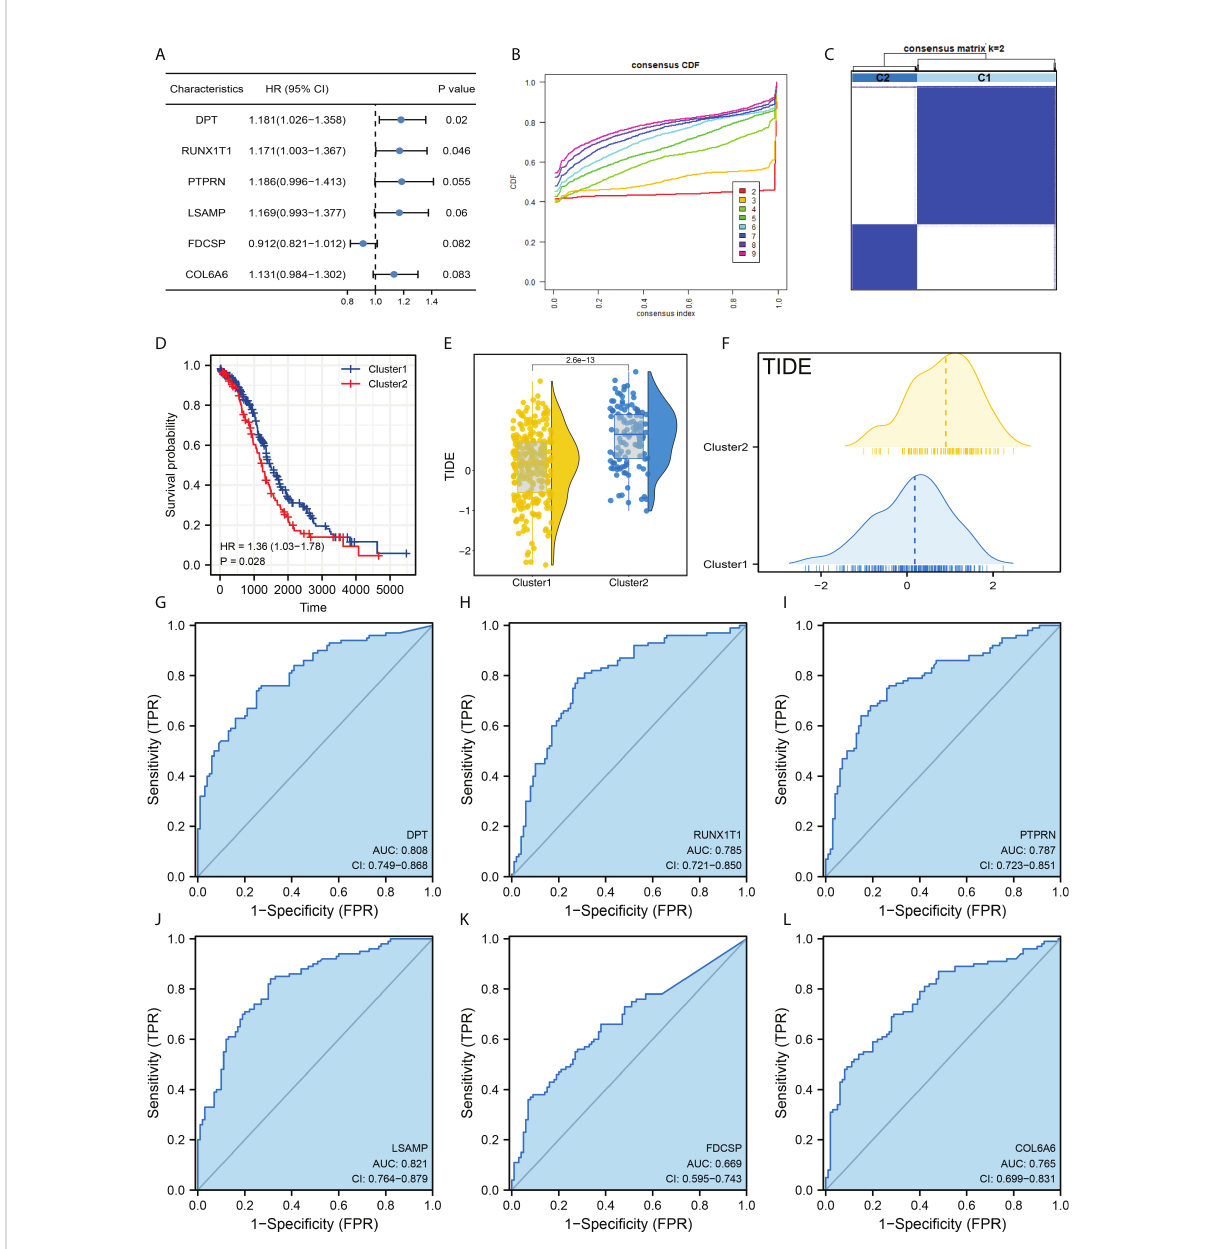
FIGURE 2 Molecular typing based on DPT, RUNX1T1, PTPRN, LSAMP, FDCSP and COL6A6. (A) Among all the characteristic genes, DPT, RUNX1T1, PTPRN, LSAMP, FDCSP and COL6A6 were identi fi ed for their prognosis correlation (P < 0.05); (B) ConsensusClusterPlus package was used for molecular typing in the patients of TCGA database; (C) Dividing patients into two subtypes provides the best differentiation; (D) KM survival curve of patients in Cluster1 and Cluster2; (E, F) The patients in Cluster2 had a higher TIDE score than Cluster1; (G – L) The prediction ability of DPT, RUNX1T1, PTPRN, LSAMP, FDCSP and COL6A6 on patients immunotherapy